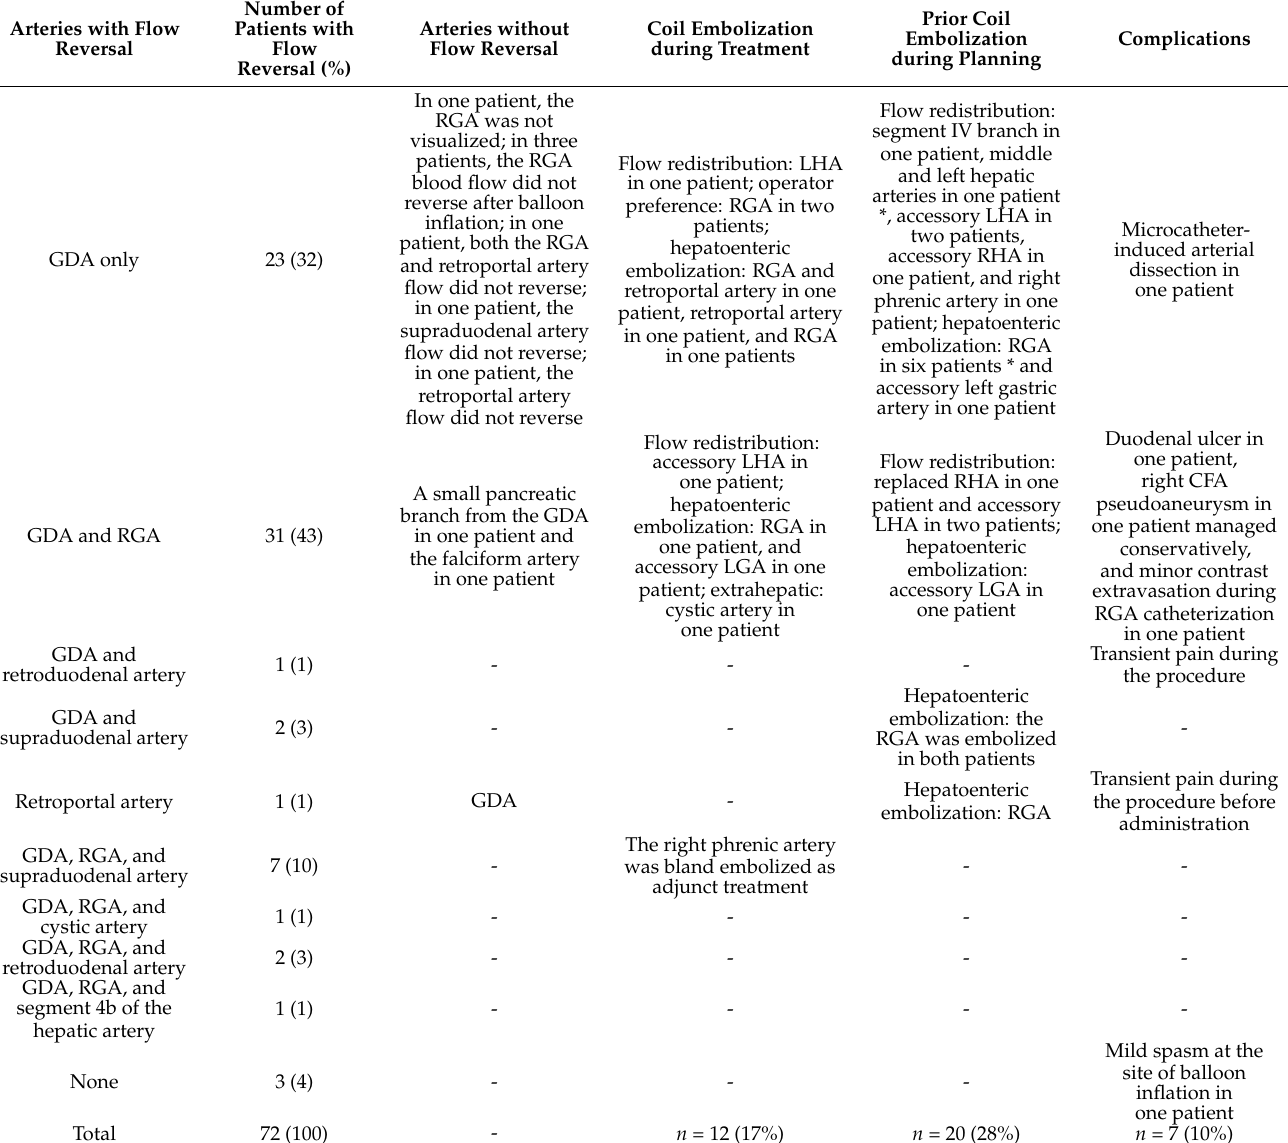
Table 3. Procedural data and complications following balloon occlusion during therapeutic 90 Y